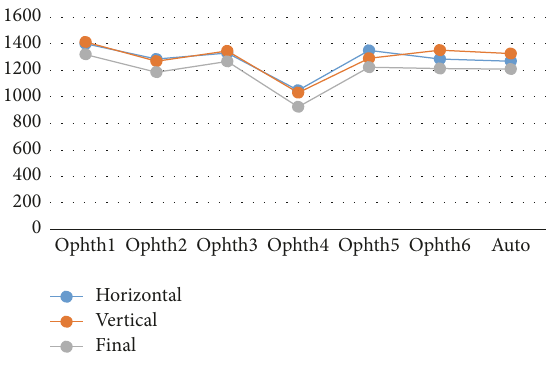
Figure 18: The total number of agreement for HCDR and VCDR and final consolidated results (four parameters). Figure 19: The percentage accuracy results for all the four param- eters. 𝑥 -axis represents the number of 6 ophthalmologists and the algorithm. 𝑦 -axis represents the accuracy